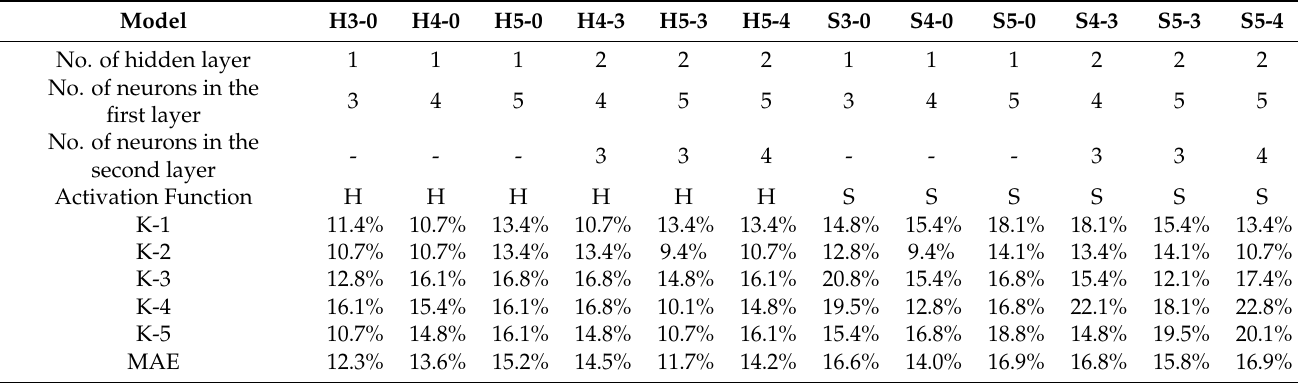
Table 8. Mean absolute error of the models.